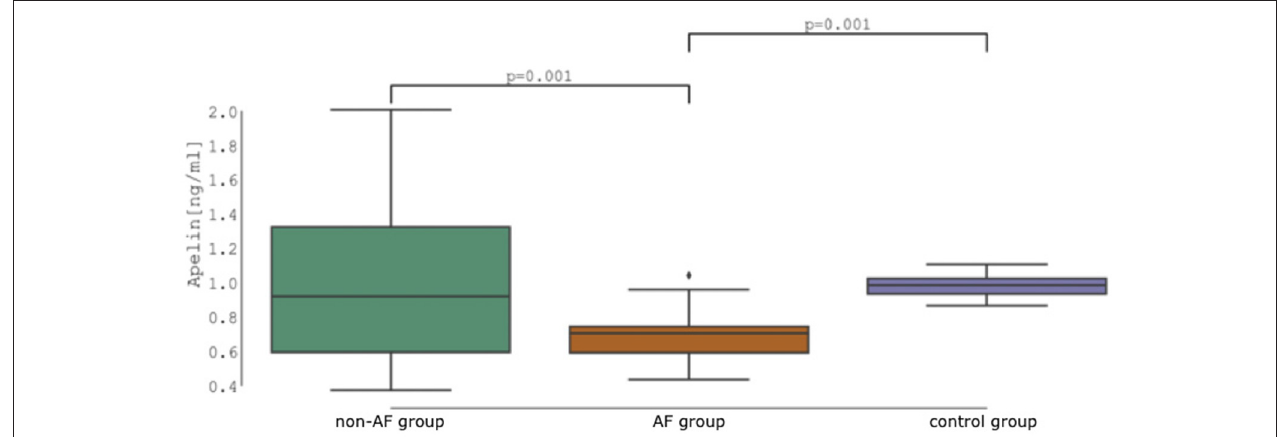
FIGURE 1 | Apelin concentration: Non-atrial fibrillation patients (non-AF group) vs. atrial fibrillation patients (AF group) vs. control group.